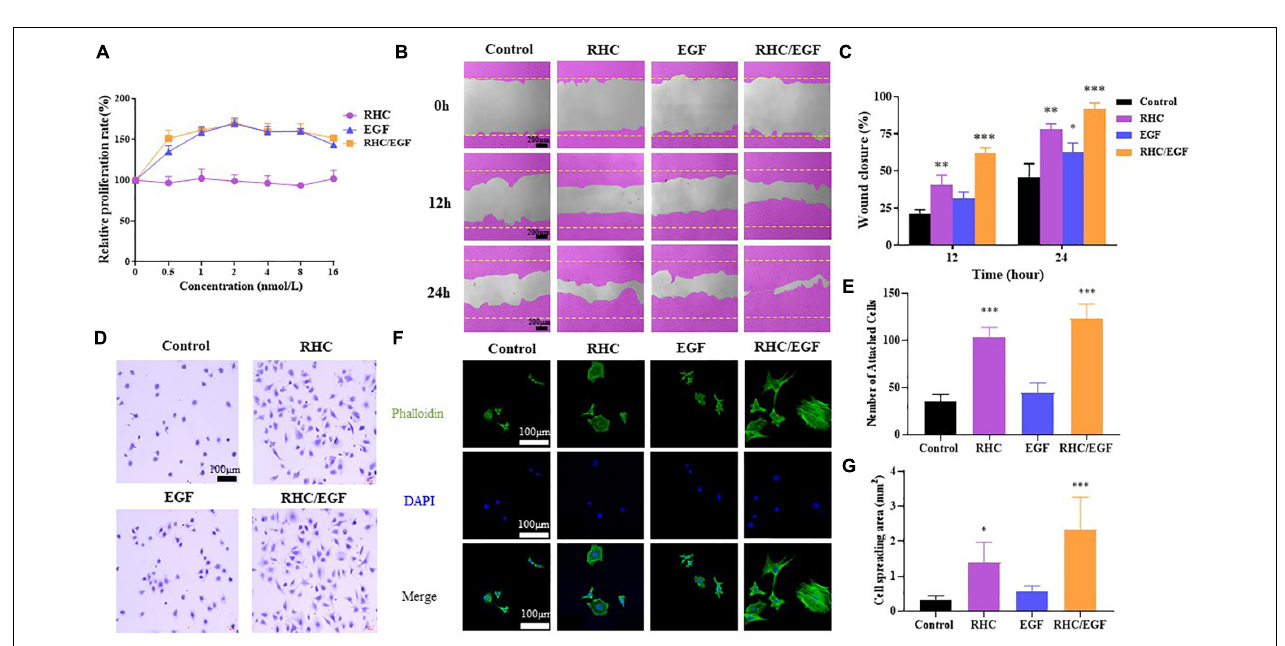
FIGURE 2 | Cell biological activity of RHC/EGF (1:1). (A) MTT assay of NIH/3T3 cell proliferation rates on RHC, EGF, or RHC/EGF. (B) Images obtained at 0, 12, and 24 h after wound creation in vitro migration assay on RHC, EGF, or RHC/EGF. (C) Quantitative analysis of gap area of HaCaT cells cultured on RHC, EGF, or RHC/EGF. (D) Optical micrographs of crystal violet–stained NIH/3T3 cells adhering to monolayers. (E) Quantitative detection of the number of adherent NIH/3T3 cells. (F) Cytoskeleton staining. (G) Quantitative calculation of cell spread area. n = 3, means ± SD, ∗ P < 0.05, ∗∗ P < 0.01, ∗∗∗ P < 0.001 vs. control